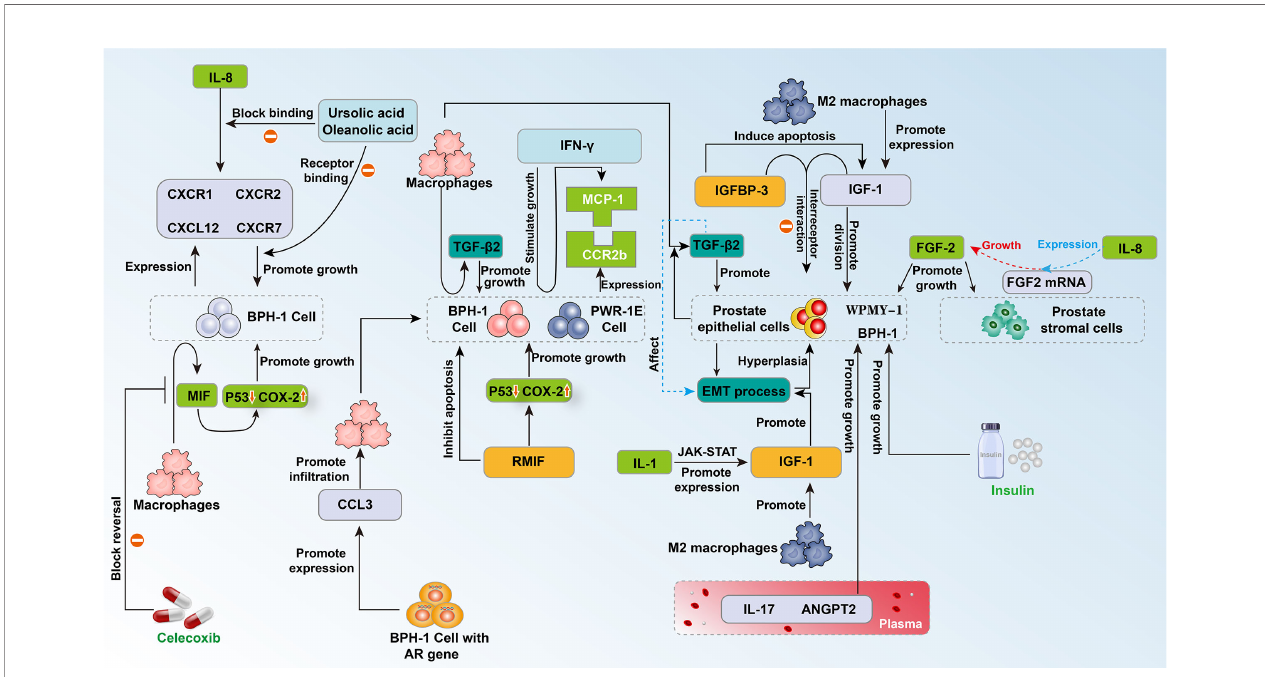
FIGURE 2 | Schematic diagram of the interaction between prostate cells and related cytokines